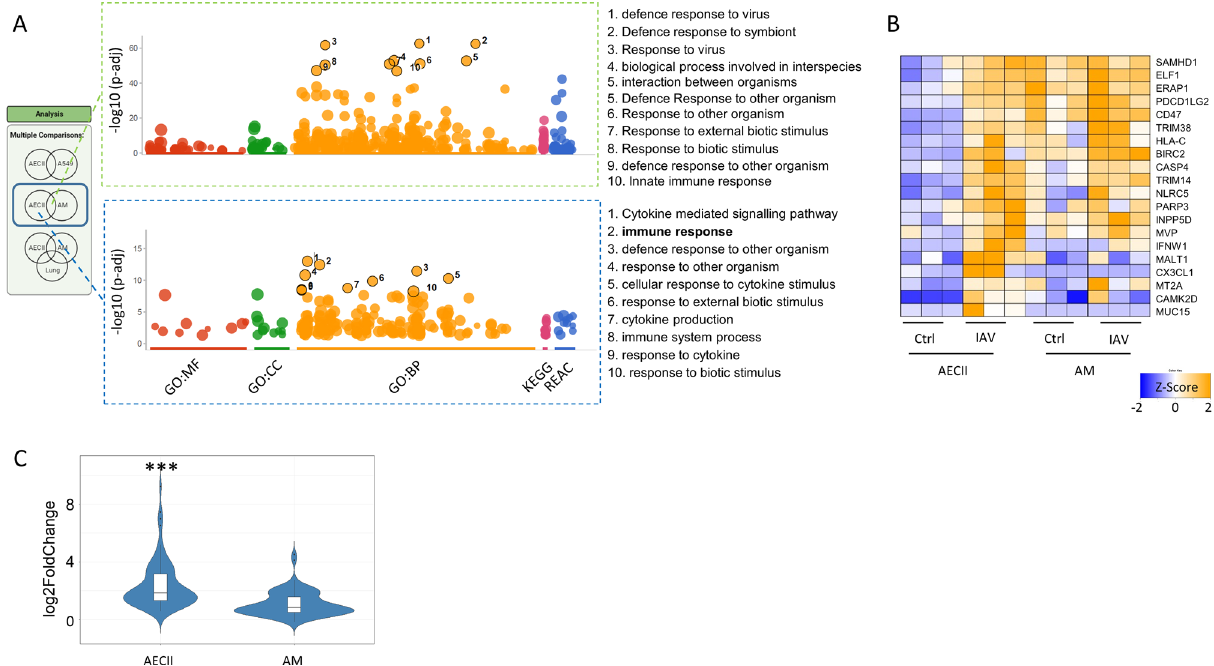
Figure 2. Comparison of virus-induced genes between AM and AEC yielded a strong shared antiviral response and a set of enriched pathways that was driven by AEC-specific genes ( A ). The top 10 of these pathways as ranked by p value are shown. Exemplary candidates from the GO term “Immune Response” show that the lack of virus induced genes from this pathway in AM is due to a high basal abundance of these genes. Z- scores were calculated on the basis of transcripts per million (TPM) ( B ). Broad lack of relative gene induction in AM was confirmed when investigating all 79 genes from this pathway that were part of the AECII-exclusive Venn section ( C ). Statistical significance was assessed by ANOVA with tukey correction for multiple testing. *** p < 0.001. Classifications: BP = biological process, CC = cell compartment, MP = molecular process, KEGG = Kyoto Encyclopedia of Genes and Genomes, REAC = reactome database. Parts of this Figure were made with